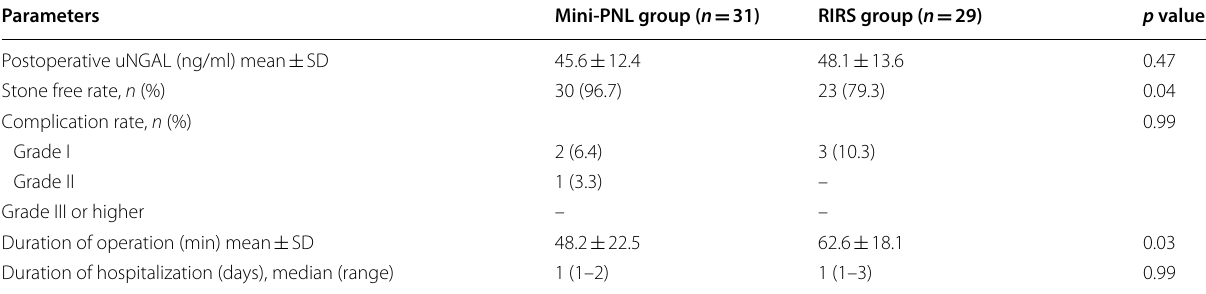
Table 2 Comparison of the two groups for the demographic and operative characteristics